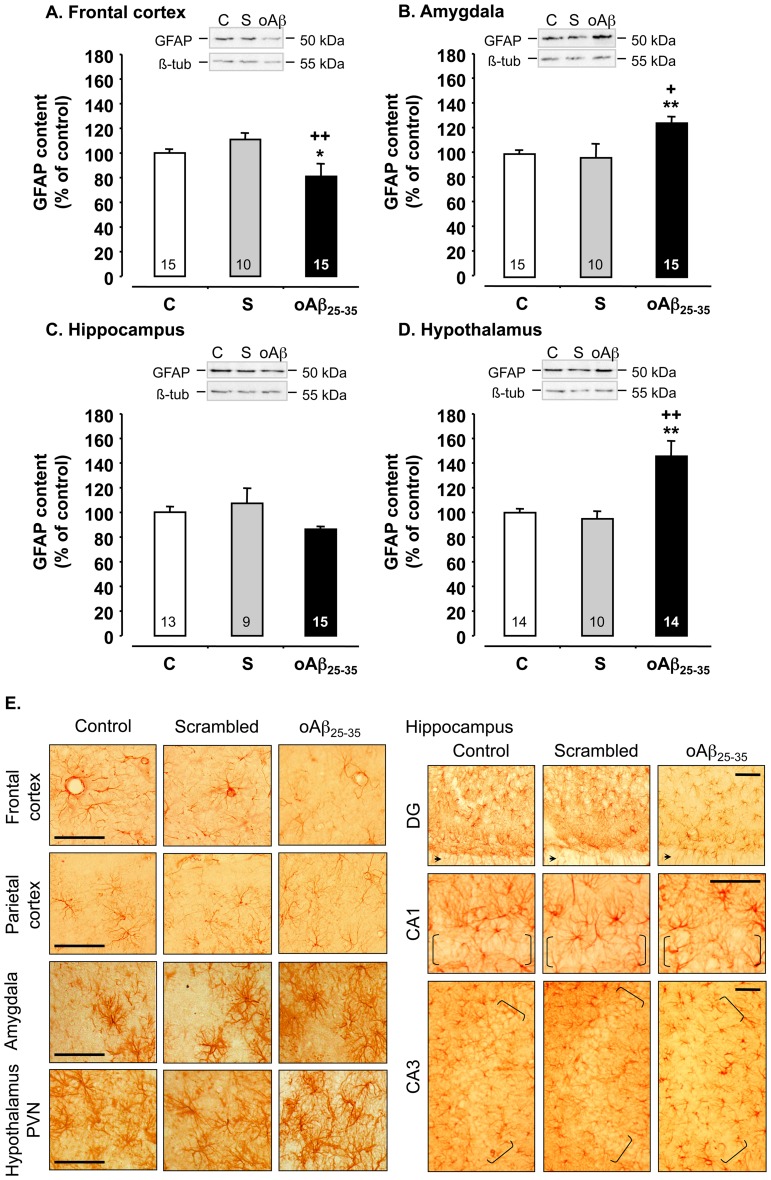
Astrocyte activation.
A. Variations in GFAP levels in the frontal cortex, amygdala, hippocampus and hypothalamus, determined in rats by western blot 6 weeks after icv injection of scrambled Aβ25–35 peptide (10 µg/rat; negative control) or oAβ25–35 (10 µg/rat). GFAP (50 kDa) variations were normalized with β-tubulin (β-tub, 55 kDa) variations and compared with untreated rats (control group: C). The results are expressed as means ± SEM. *p<0.05 and **p<0.01 vs. control group, +p<0.05 and ++p<0.01 vs. scrambled treated rats. The number of animals in each group is indicated within the columns. B. Effects of oAβ25–35 (10 µg/rat) icv injection on astrocyte reactions using GFAP immunolabeling into the frontal and parietal cortex, amygdala, hippocampus (CA1, CA2 & CA3 regions) and hypothalamus (periventricular nucleus: PeVN & paraventricular nucleus: PVN) determined in control (C) untreated rats and 6 weeks after Aβ25–35 injection. The scrambled peptide injection (10 µg/rat) served as negative control and did not induce any modifications in the GFAP signal. 3v: third ventricle. brackets: hippocampus layer of granular cells layer. Scale bar  = 60 µm.